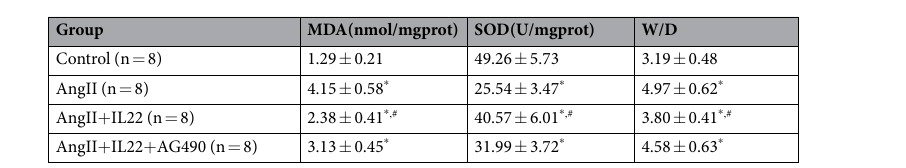
Table 1. Determination of MDA, SOD and W/D. * P < 0.05, compared with control group; # P < 0.05, compared with AngII group and AngII + IL22 + AG490